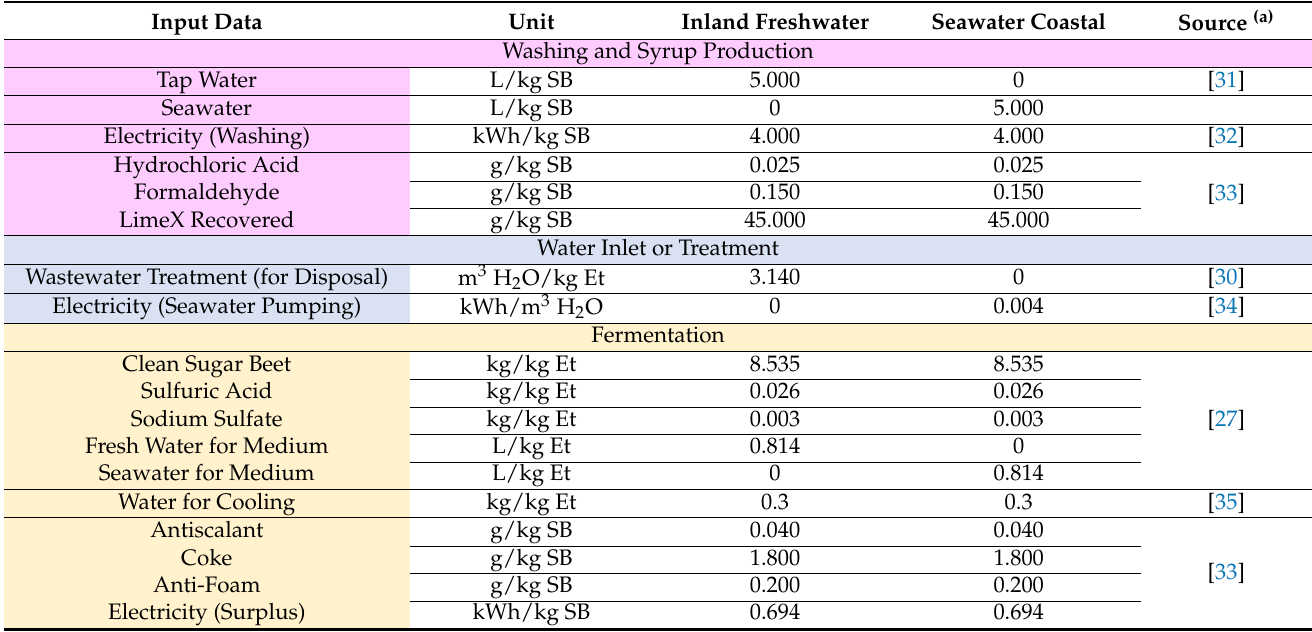
Table 2. Life cycle inventory of sugar beet to ethanol conversion.